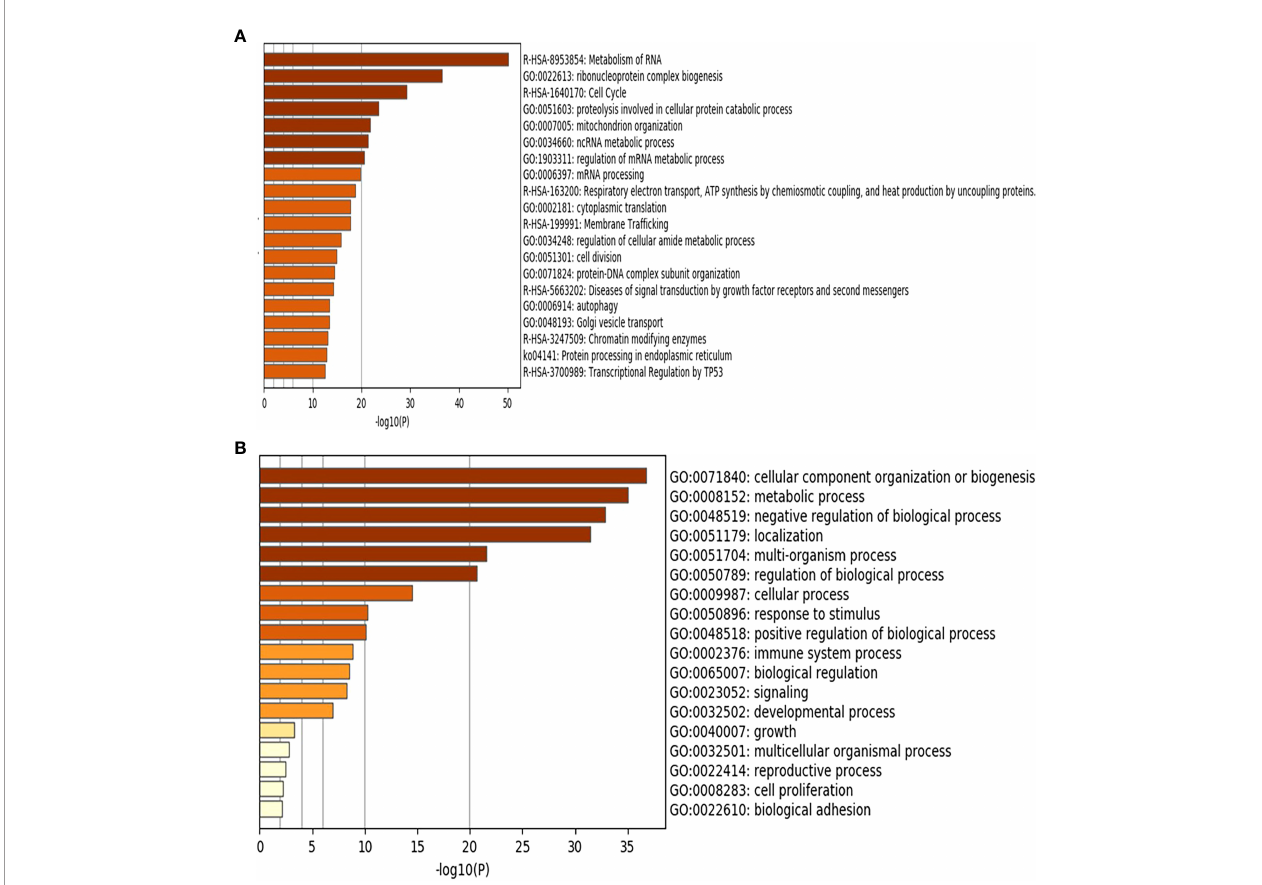
FIGURE 3 | Gene Set Enrichment Analysis (GSEA) of the differentially expressed genes showing the upregulated pathways in late stages of CRC (n=6) compared to early stages (n=5) using Metascape (http://metascape.org): a gene annotation and analysis online resource generating a graphical presentation. (A) Using Reactome and KEGG databases. (B) Using GO